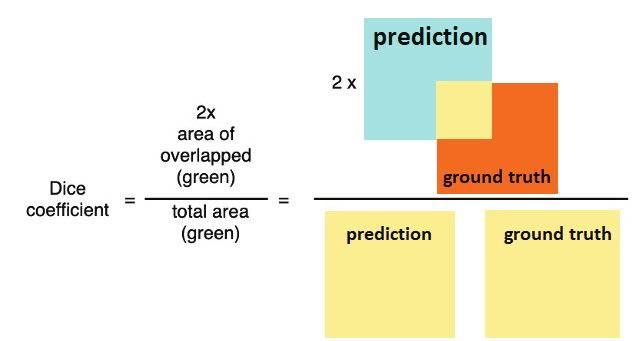
Figure 3. Dice coefficient calculation